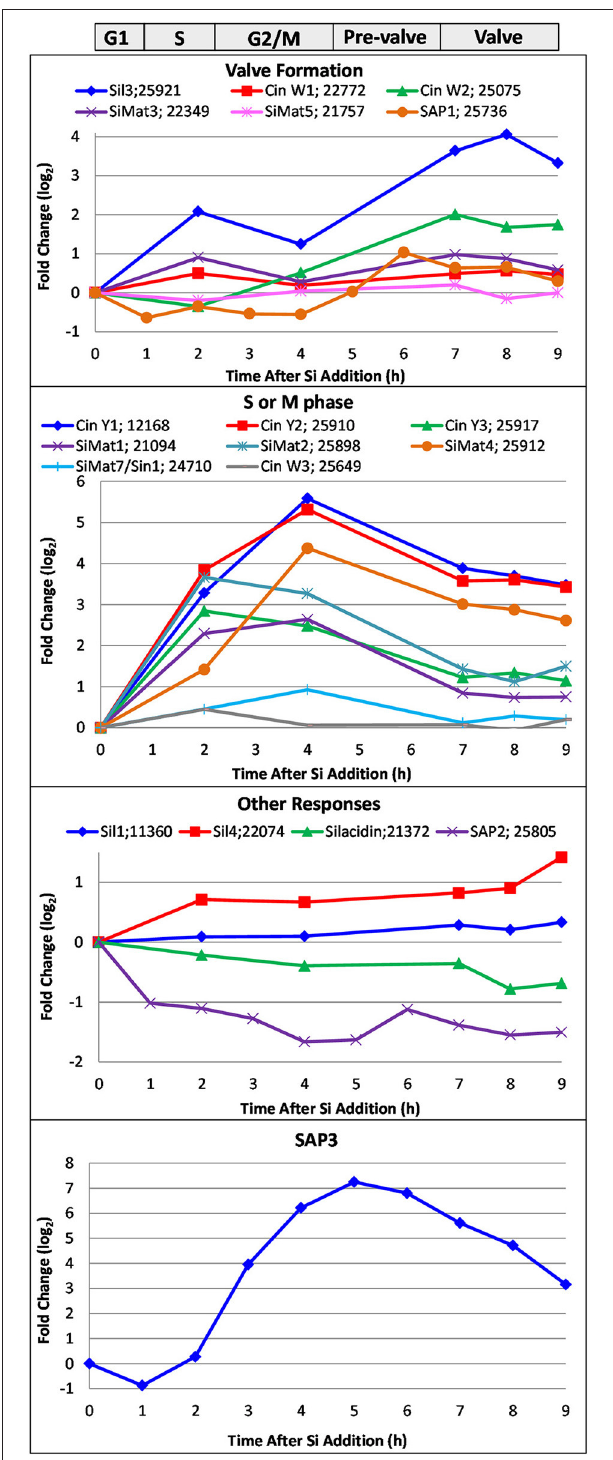
FIGURE 9 | Whole genome microarray analysis of transcript level changes of proteins known to be involved in silicification in T. pseudonana . Log base 2 fold changes relative to 0h are plotted. Transcripts were measured in a synchronized culture where cell cycle progression began after silicic addition to a silicon-starved culture. Approximate timing of different cell cycle stages are shown at top. Data are from Shrestha et al. (2012).